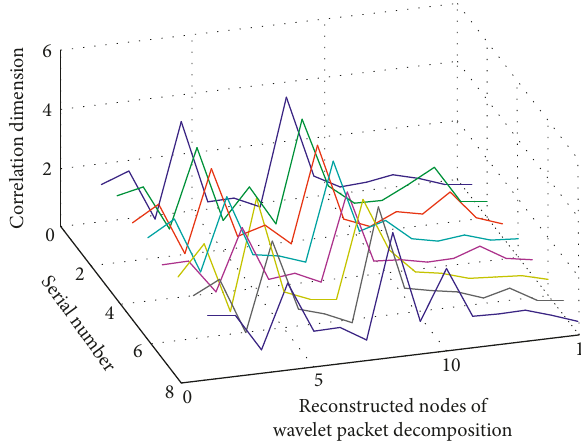
Figure 18: Correlation dimension spectra (1000r/min).